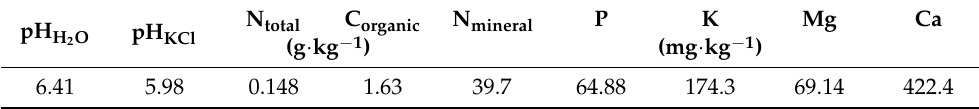
Table 2. Properties of the soil on which the experiment was